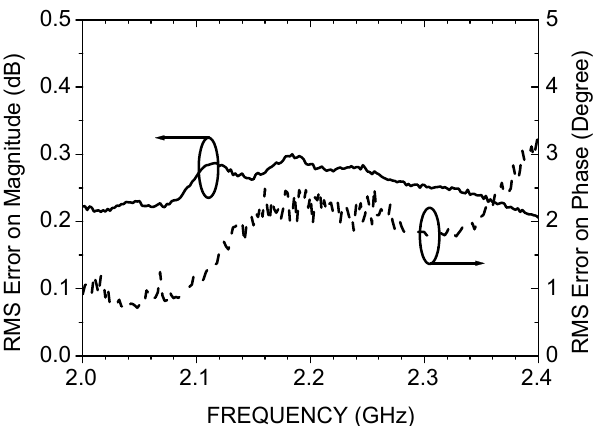
Figure 8. RMS measurement errors in the 256 control states of the phase shifter.